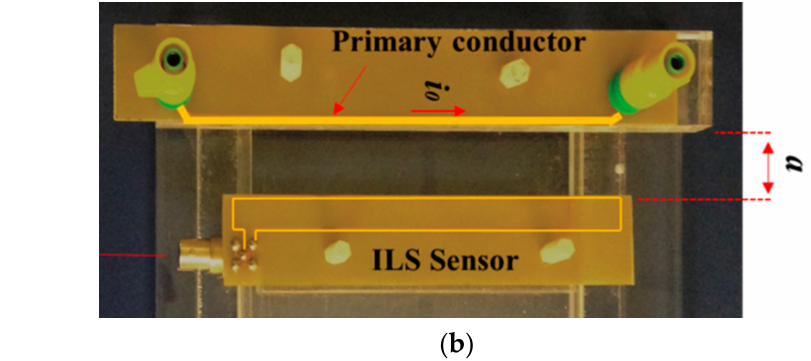
Figure 8. ILS sensor: ( a ) working principle based on Faraday’s law, and ( b ) arrangement with the primary conductor carrying the PD pulse [87].